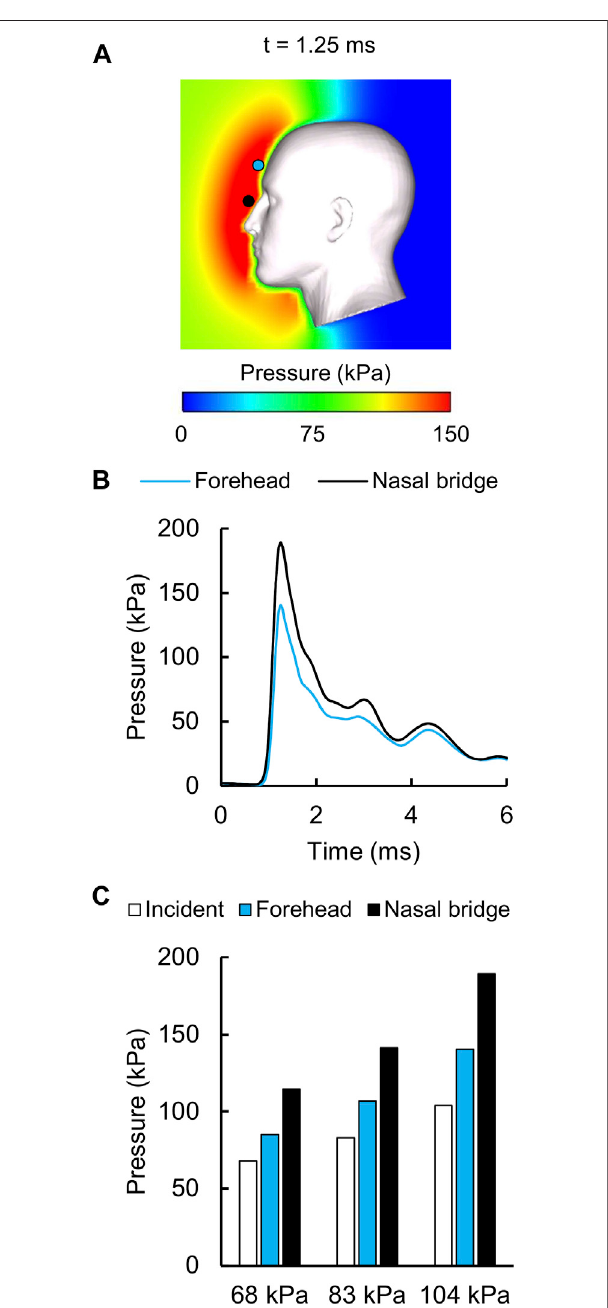
FIGURE 4 | Re fl ected air pressure near the human head in the shock tube. (A) Contour map showing the model-predicted peak re fl ected pressure for the 104 kPa blast overpressure at t (cid:1) 1.25 ms into the simulation. (B) Temporal pro fi le of the predicted re fl ected pressure at the nasal bridge (black circle) and the forehead (blue circle). (C) Bar graph comparing the measuredincidentpressuresandthepredictedre fl ectedpressuresforthe68, 83, and 104 kPa blast